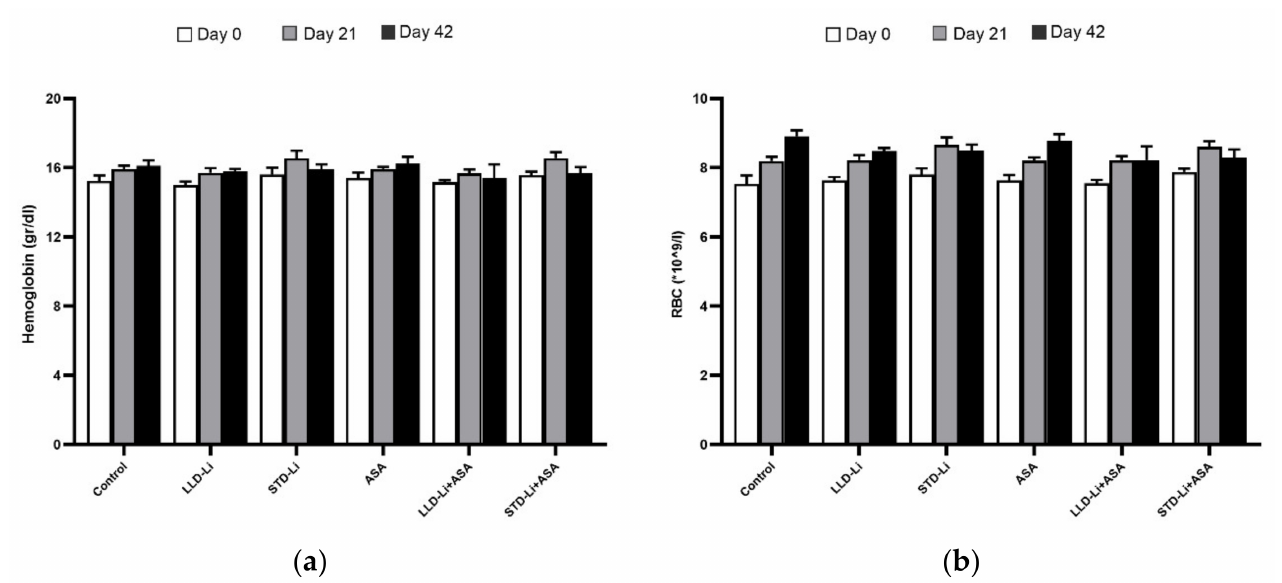
Figure 8. Blood hemoglobin and red blood cell levels in aspirin + Li-treated rats. Rats were fed regular food (control) or lithium-containing food [LLD-Li or STD-Li] for 42 days. Low-dose ASA (1 mg/kg, ip) was administered alone or together with Li. On the indicated days, blood was collected, and hemoglobin levels and red blood cell count were measured as described in Materials and Methods. Results are the means ± SEM of a single representative experiment out of two demonstrating a similar pattern with 6–8 rats per group in the depicted experiment. ( a ) Hemoglobin—One- way ANOVA: Day 0— p = 0.547; day 21— p = 0.07; day 42— p = 0.29. ( b ) RBC—One-way ANOVA: Day 0— p = 0.547; day 21— p = 0.07; day 42— p = 0.294. Abbreviations: ASA—acetylsalicylic acid, LLD—low-low dose, Li—lithium, STD— standard